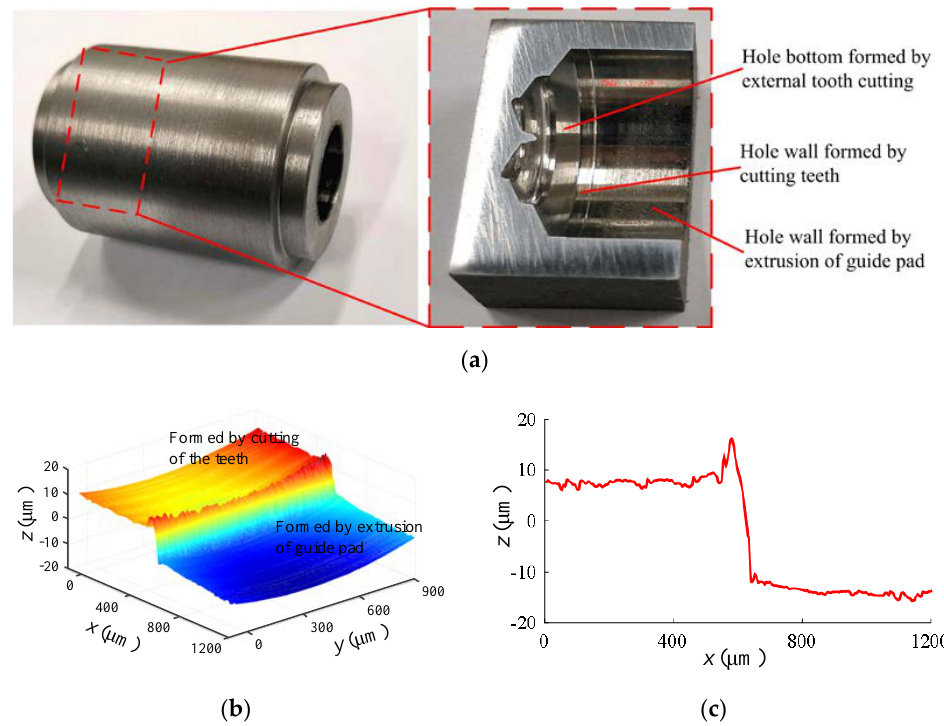
Figure 13. Measurement of total plastic deformation of guide pads and hole wall: ( a ) section piece of deep hole drilling specimen; ( b ) 3D morphology of hole wall deformation zone; ( c ) extraction of total extrusion deformation.